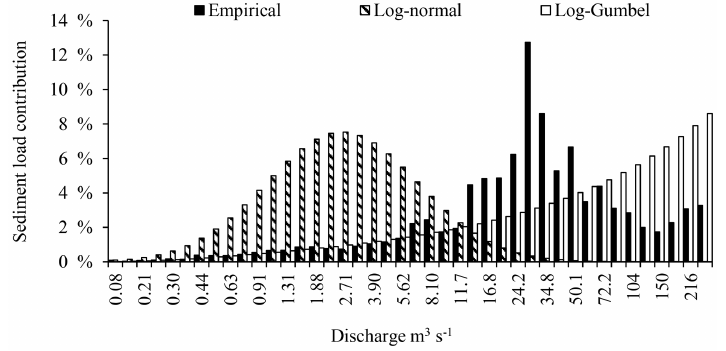
Figure 13. Three sediment load histograms obtained from the dataset, from the product of the rating curve times to the log-normal distribution of discharge, and from the product of the rating curve times to the log-Gumbel distribution.